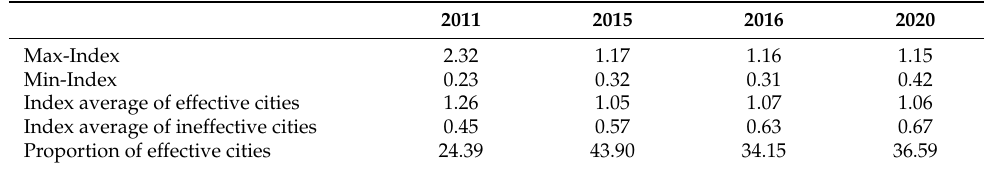
Figure 7. Analysis on the technical efficiency of real estate inventory in Yangtze River Delta. Table 3. The technical efficiency index of real estate inventory in the Yangtze River